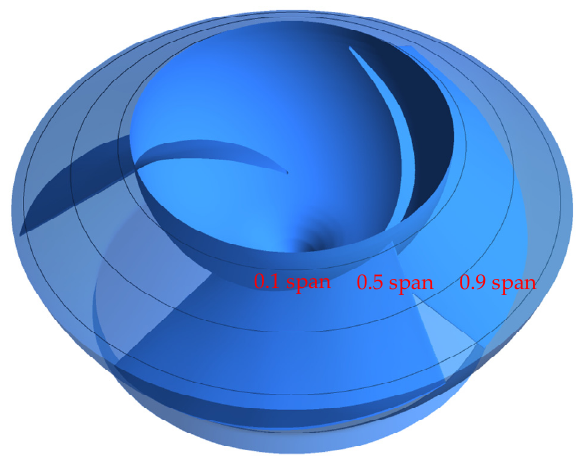
Figure 8. Schematic diagram of span position.